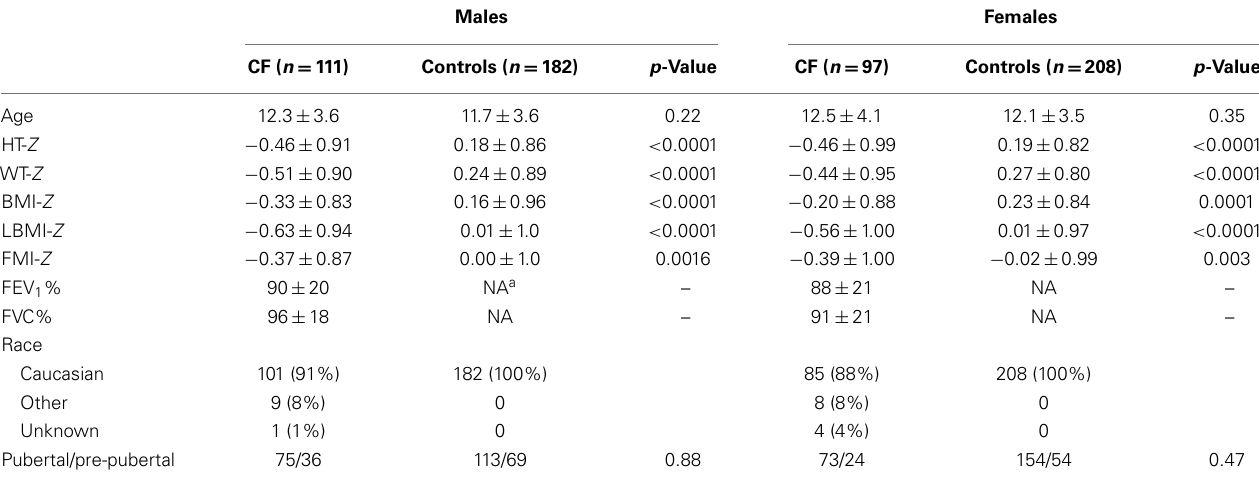
Table 1 | Characteristics of subjects (mean ±